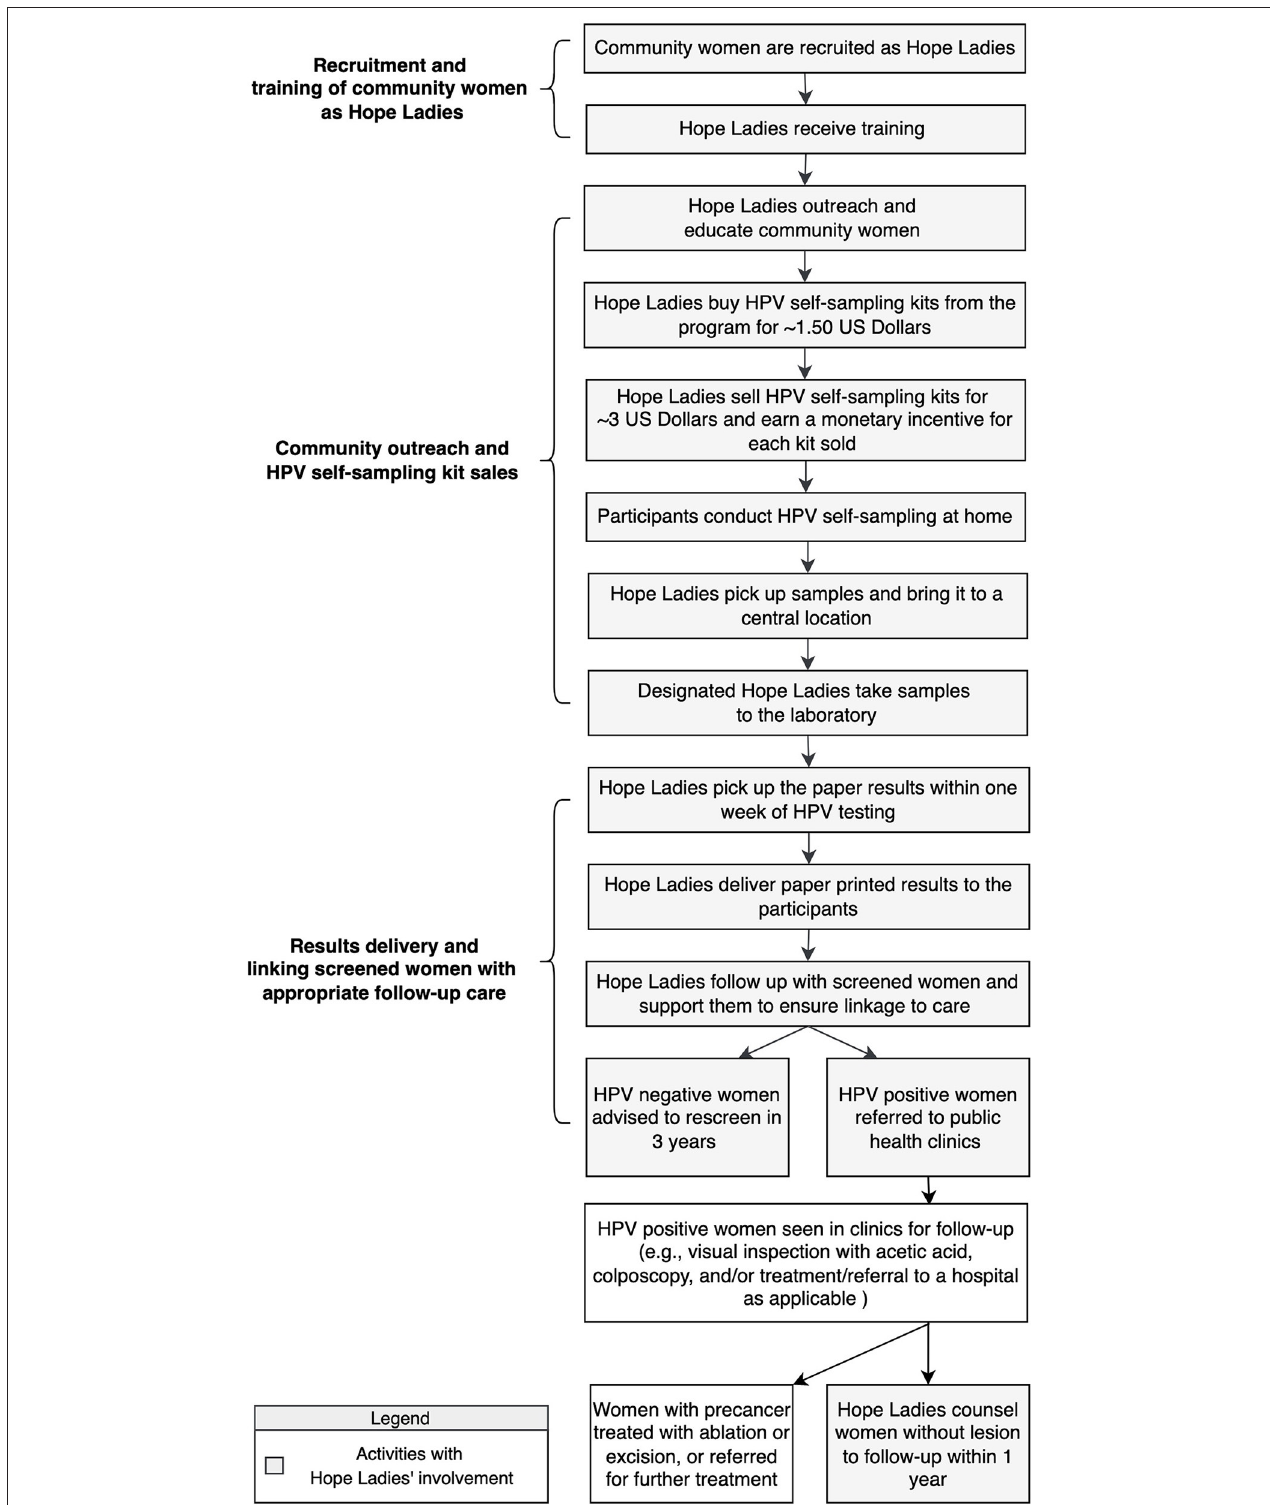
FIGURE 1 | Activities within the Hope Project social entrepreneurship.